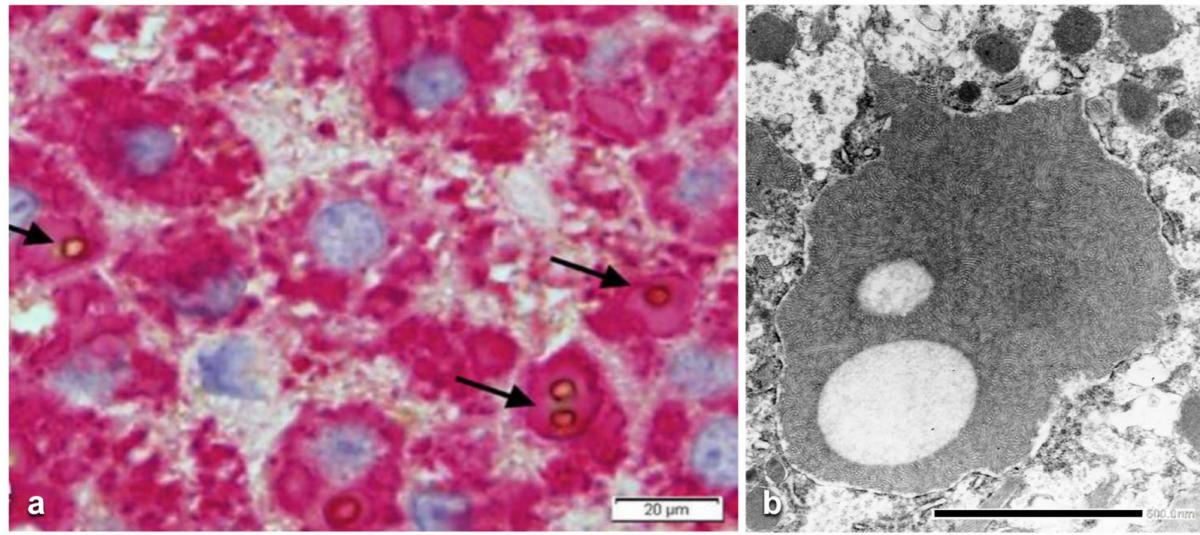
Figure 17. HHHS patient with Hypo-AOOO-B lipoproteinemia. Hepatocytes contain plenty of fibrinogen immunoreactive material (red color), inside fibrinogen inclusions there are rounded inclusions positively stained by an anti-APO-B lipoprotein antibody (arrows). ( a ) double immunostaining × 1000. The electronmicrophotograph shows a single fibrinogen inclusion in a dilated cistern of the RER. The inclusion consists of closely packaged tubular structures with a finger print-like appearance. A lipid droplet is present within the fibrinogen inclusion ( b ) (EM ×